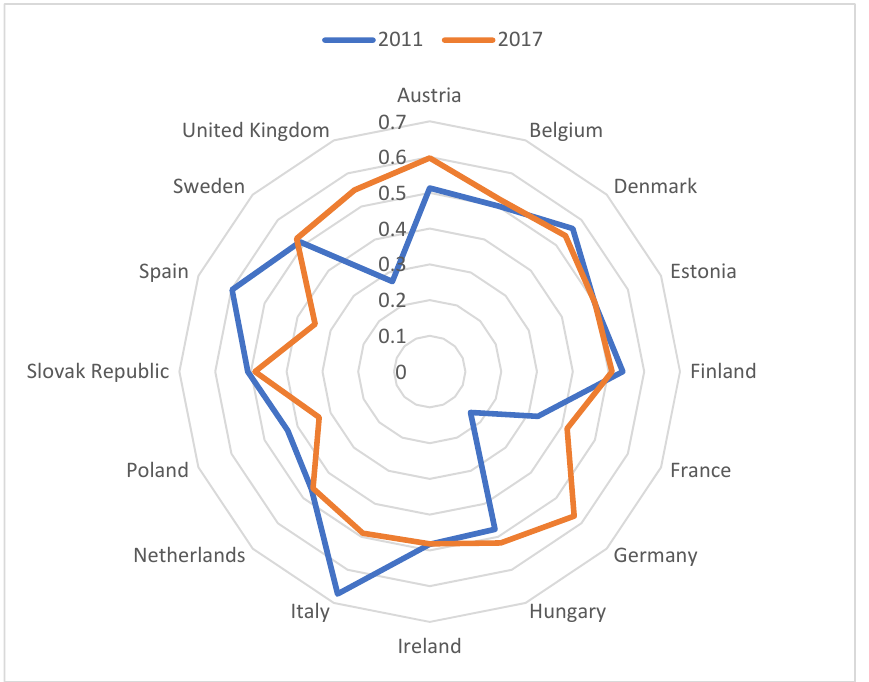
Figure 8. The average level of environmental performance of other power and storage technologies R&D (million USD and PPP) for selected EU countries in 2011 and 2017.